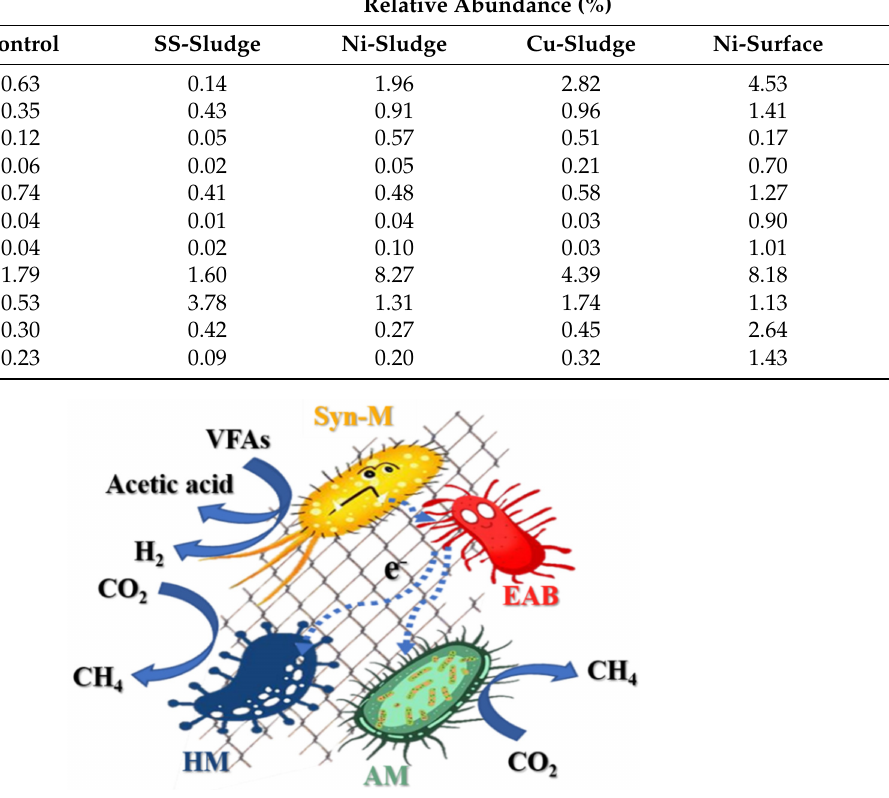
Figure 9. Possible methanogenic process in metal meshes mediated AD (DIET: direct interspecies electron transfer, EAB: electrochemical active bacteria, AM: acetotrophic methanogens, HM: hy- drogenotrophic methanogens, Syn-M, syntrophic